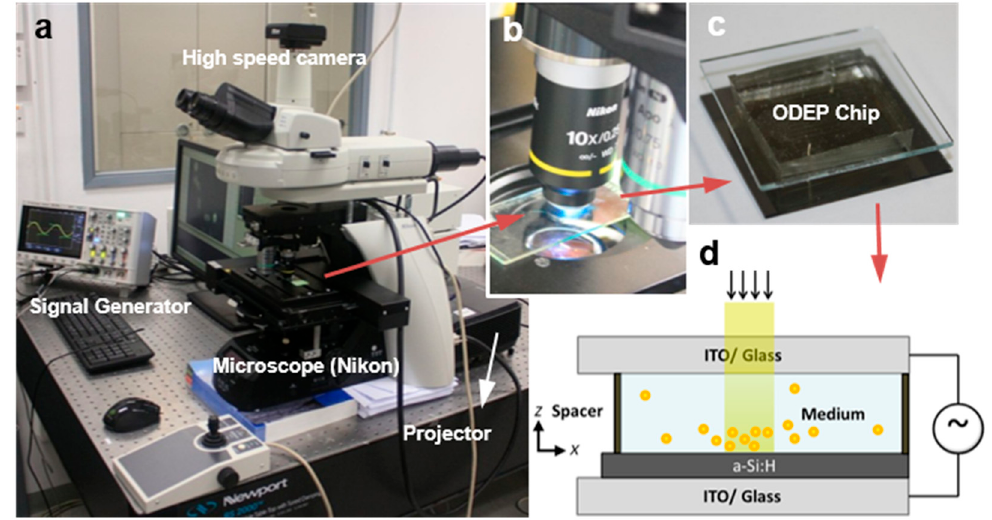
Figure 2. Experimental setup of an OEK system. ( a ) The complete OEK system; ( b ) the light from a digital projector passing through the chips. The cell rotation images are obtained by a high-speed CCD placed to the top of the microscope; and ( c ) the structure and ( d ) the working principle of the OEK chip.